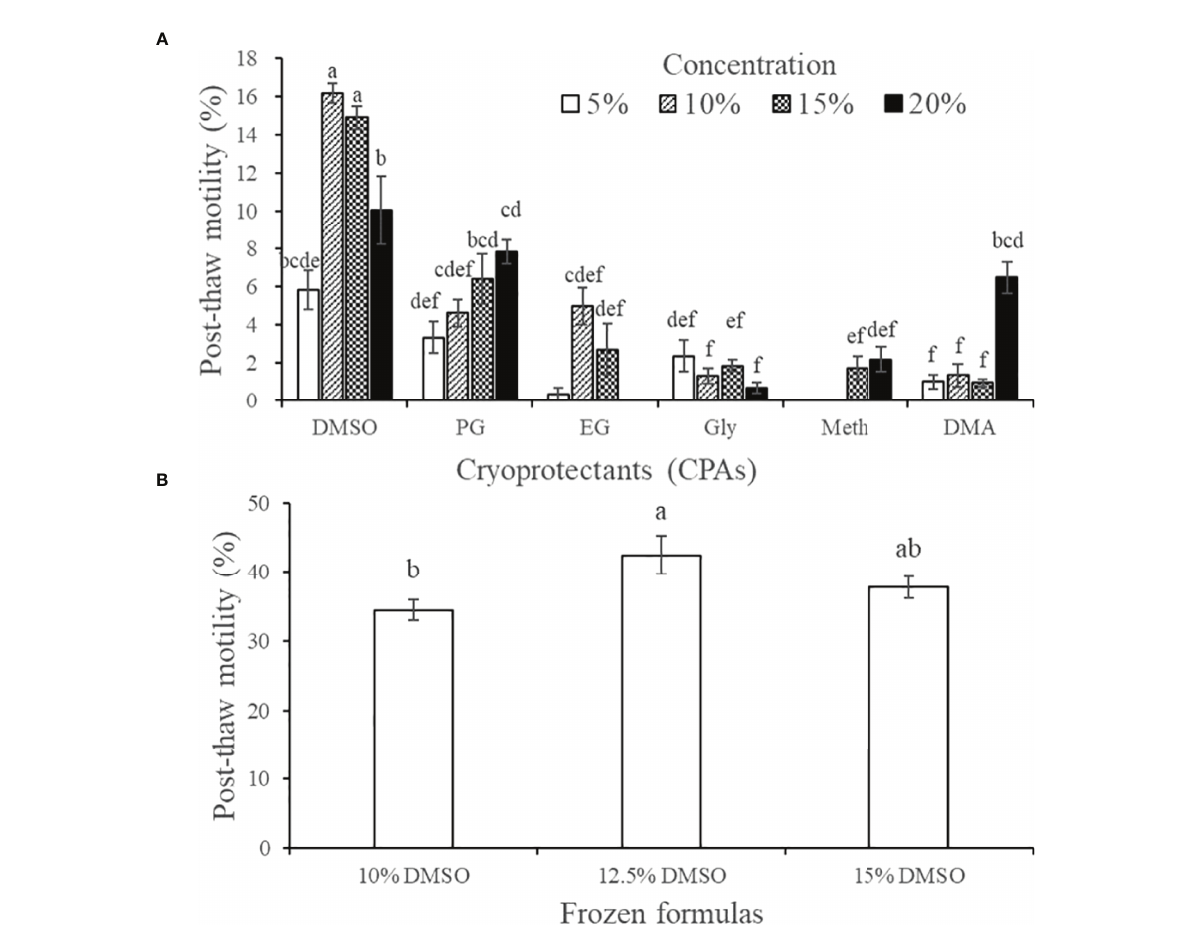
FIGURE 5 Effect of cryoprotective agents on the post-thaw motility of A. japonicus spermatozoa. (A) Preliminary screening results of six CPAs at four concentrations; (B) Further screening results of the optimal concentration of DMSO. Data are presented as the means ± SE (n = 4). Different letters indicate signi fi cant differences (P < 0.05). Data were not transformed when performing one-way ANOVA. Note: One-way ANOVA was performed on all treatment groups in A with a normal distribution, and discarding obviously invalid treatment group